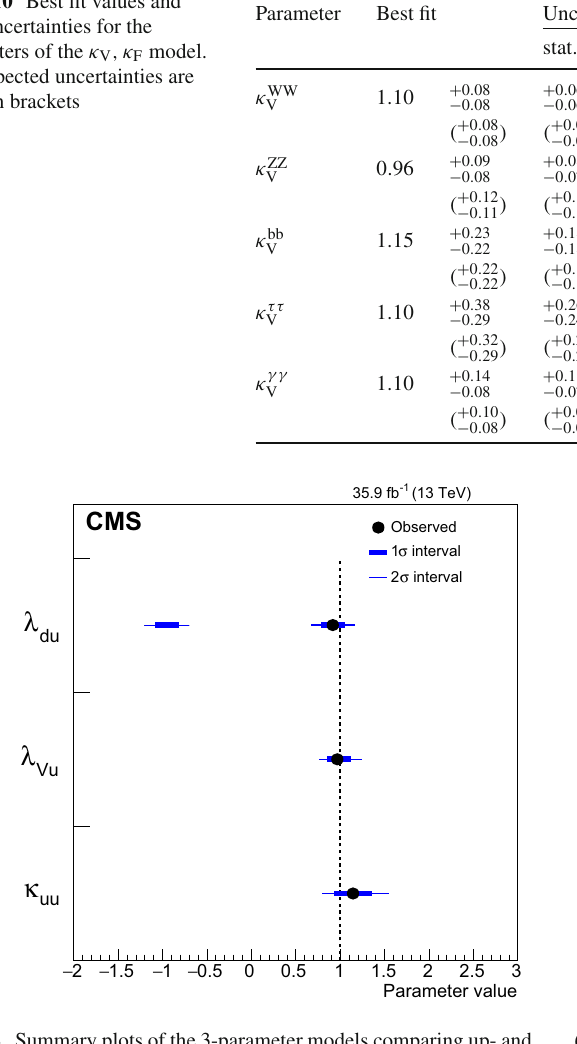
(right). The points indicate the best fit values while the thick and thin horizontal bars show the 1 σ and 2 σ CL intervals, respectively. Both positive and negative values of λ du , λ Vu , λ lq , and λ Vq are considered /Γ H q